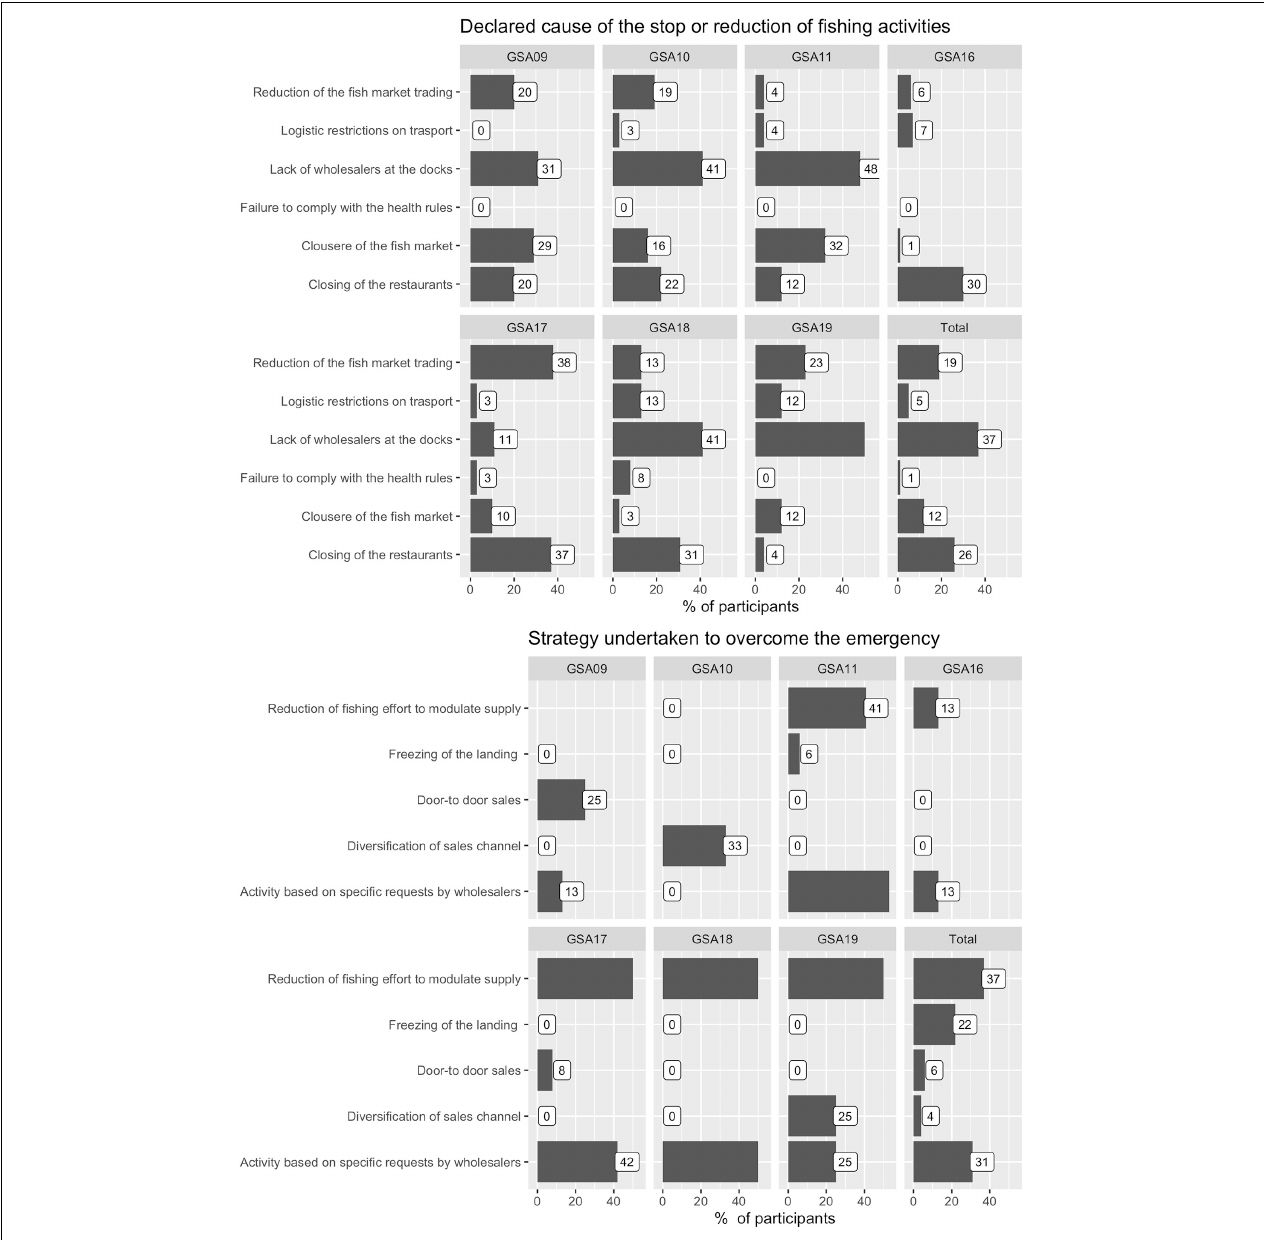
FIGURE 10 | Barplot showing the responses of the participants to the socio-economic